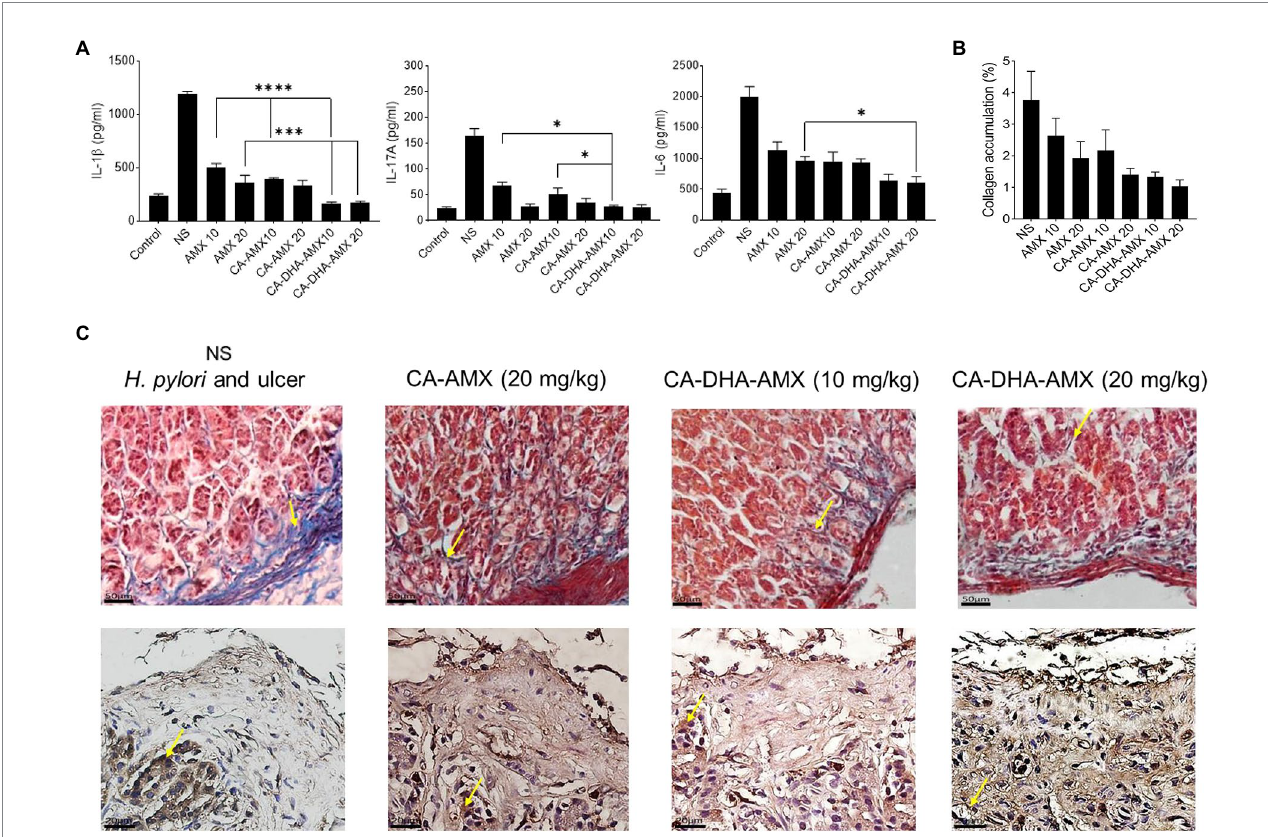
FIGURE 8 The histopathological evaluation and the pro-inflammatory cytokine production of gastric biopsies. (A) The levels of pro-inflammatory cytokines including IL-1 β , IL-6, and IL-17A was conducted using ELISA method. (B) The collagen accumulation among different treated groups. (C) Masson’s trichrome staining was used to evaluate the accumulation of collagen (yellow arrow), the blue and red are responsible for collagen and muscle fibers. Immunohistochemical staining for Collagen I (yellow arrow), high accumulation of collagen I in glands and endothelia observed in untreated group, while the accumulation was reduced in treated groups, the lowest accumulation was observed in CA-DHA-AMX (20 mg/kg). Data are presented as mean ± SEM ( n =